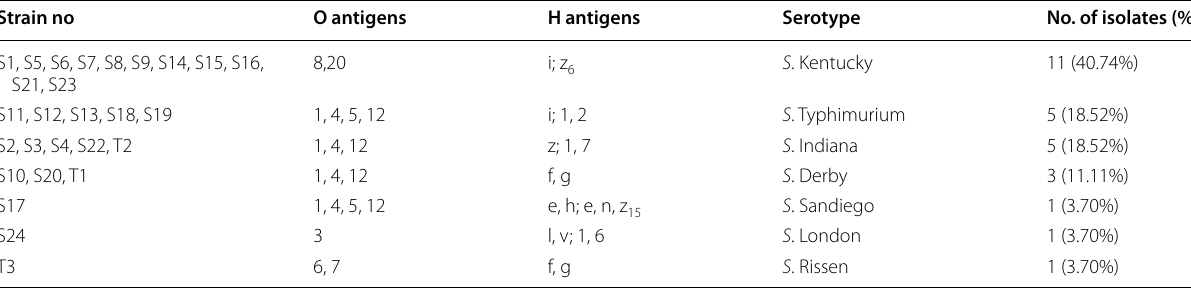
Table 2 Serotype distribution of 27 Salmonella isolates Strain no O